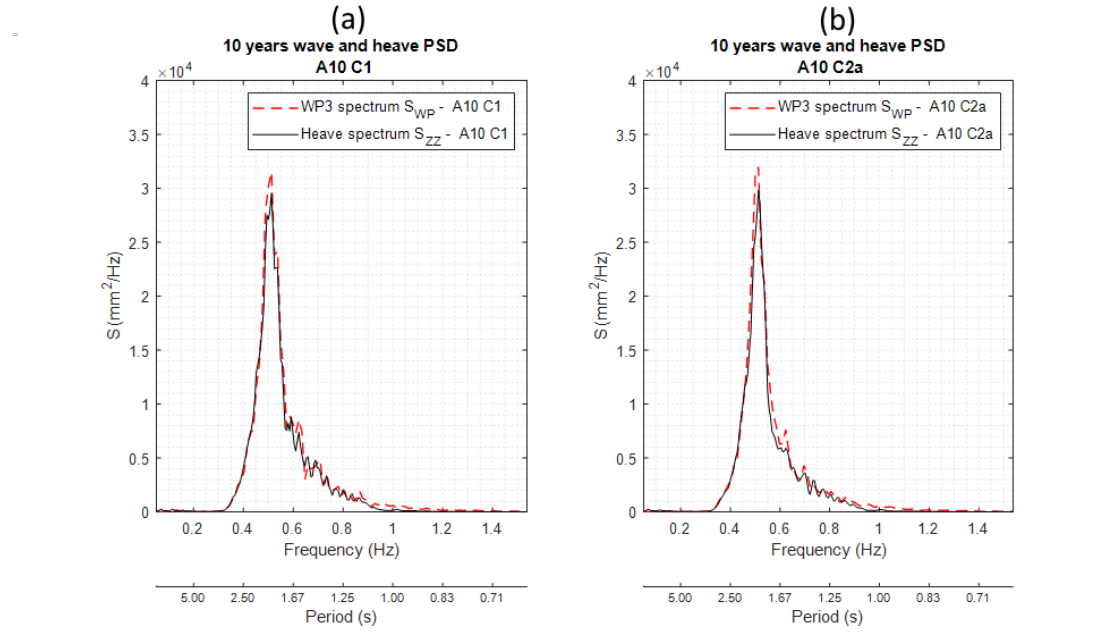
Figure 21. Heave motion spectral density for C1 ( a ) and C2a ( b ) 10-year wave.